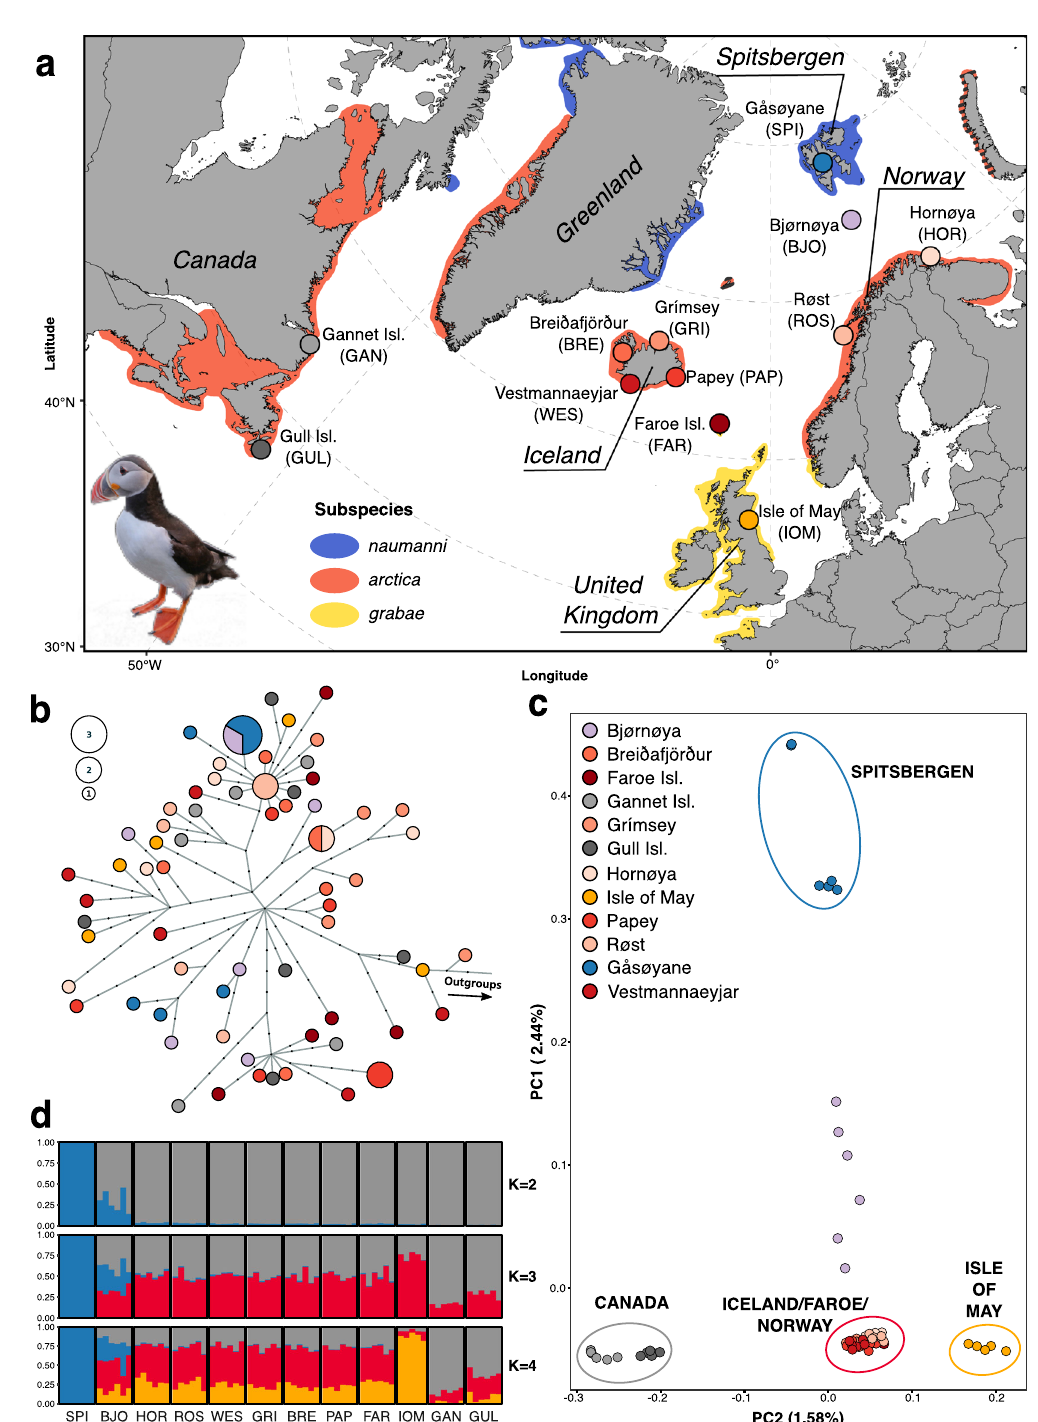
Fig. 1 Sampling distribution and genomic structure of 71 Atlantic puf fi n individuals across 12 colonies throughout the breeding range. a Map presenting the location of the 12 sampling sites. Color shading indicates the breeding range of the species as a whole, as well as the recognized subspecies. b Mitochondrial haplotype network based on a maximum likelihood tree generated with IQTree and visualized using Fitchi. It contains 66 unique haplotypes identi fi ed by 192 mitogenome-wide SNPs. Sizes of circles are proportional to haplotype abundance. Color legend is provided in ( c ). Black dots represent inferred haplotypes that were not found in the present sampling. c Principal component analysis (PCA) using genotype likelihoods at 1,093,765 polymorphic nuclear sites calculated in ANGSD to project the 71 individuals onto PC axes 1 and 2. Each circle represents a sample and colors indicate the different colonies. The percentage indicates the proportion of genomic variation explained by each axis. The color coding of the colonies is consistently used throughout the manuscript. d CLUMPAK- averaged admixture plots of the best K ’ s using the same genotype likelihood panel as in ( c ). Each column represents a sample and colonies are separated by solid white lines. Optimal K ’ s were determined by the method of Evanno et al. 41 (see Fig. S6a) and colors indicate the ancestry fraction to the different clusters. The dataset(s) needed to create this fi gure can be found at https://doi.org/10.6084/m9. fi gshare.14743242.v1.